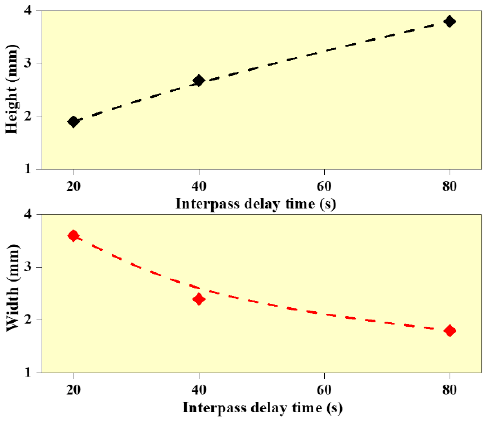
Figure 4. Effect of interlayer delay on wall height and wall width.